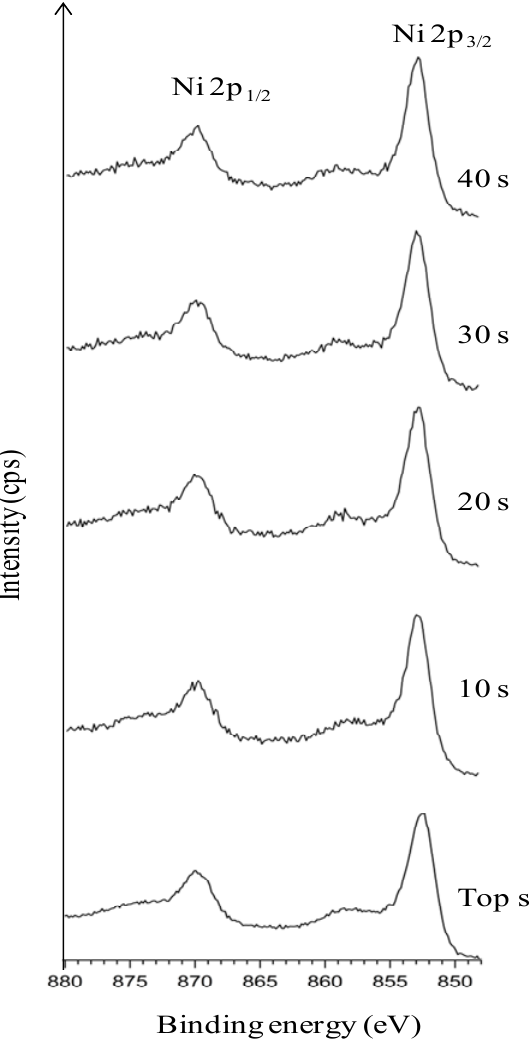
Figure 8. XPS depth profile studies of Ni peaks in substrate after thermal